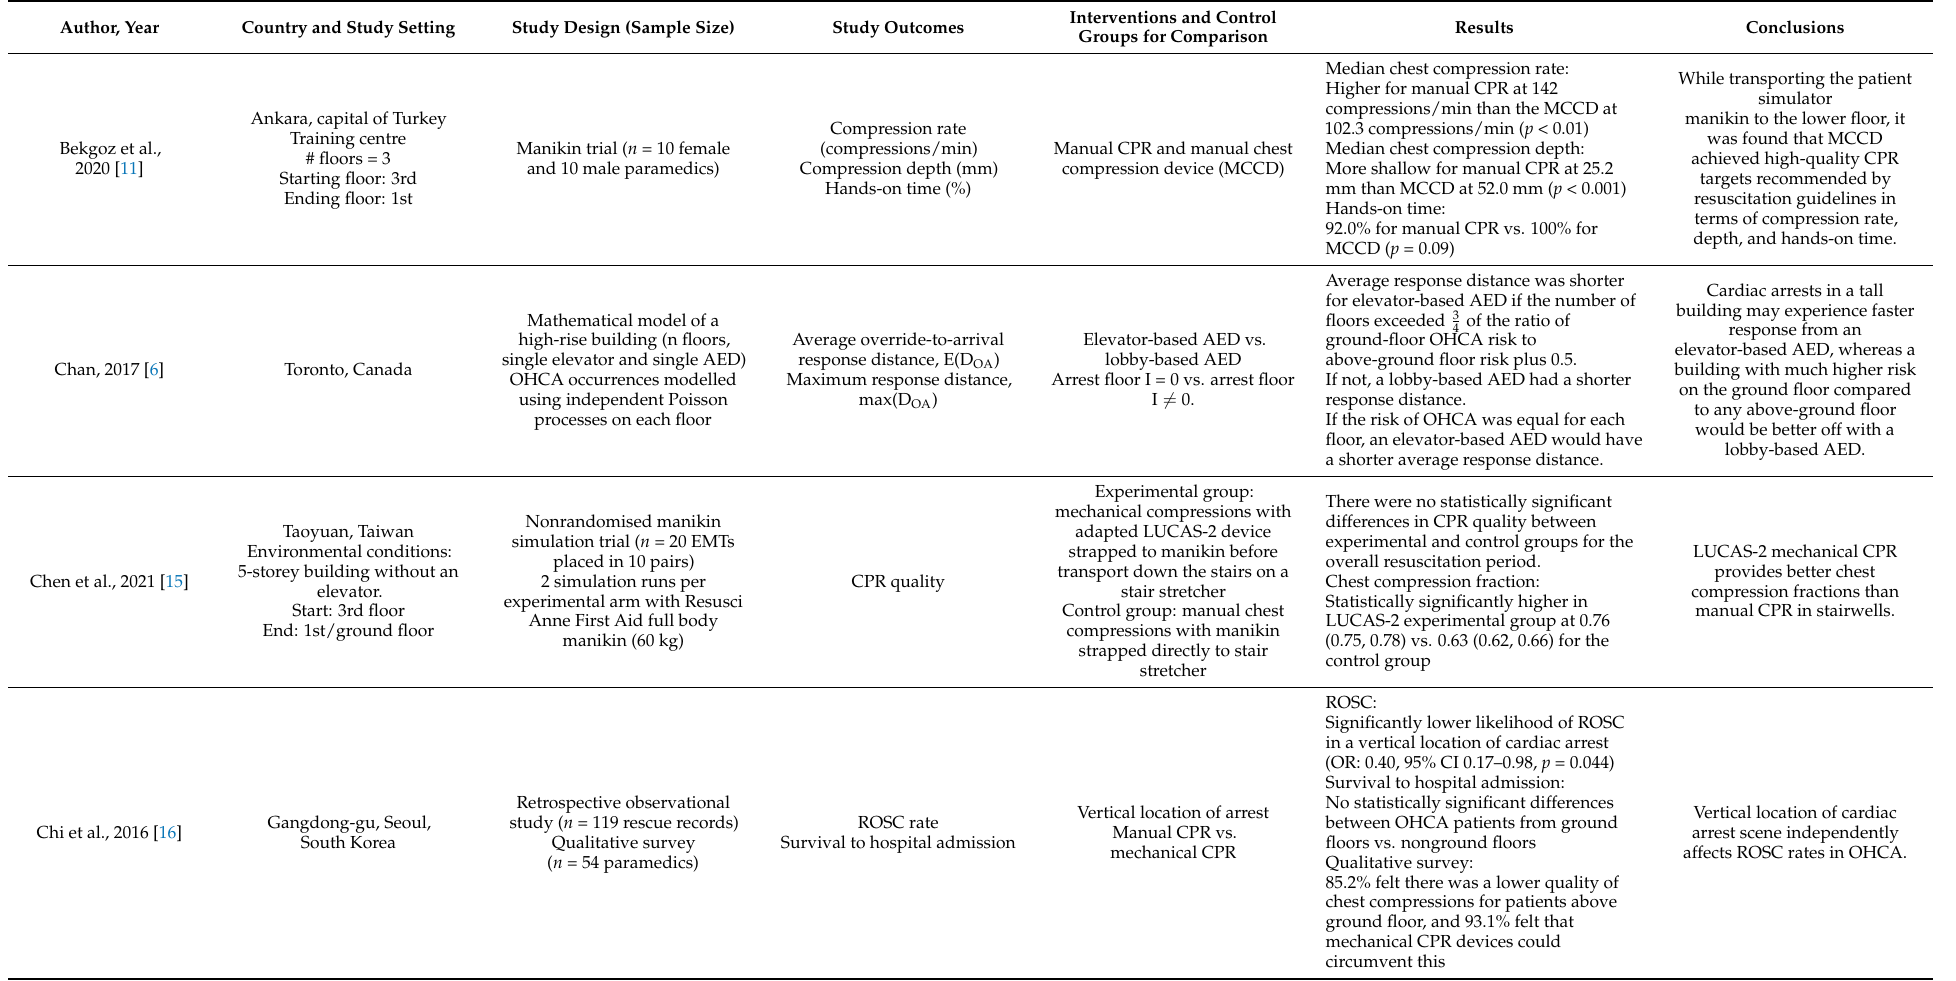
Table 1. Characteristics of included